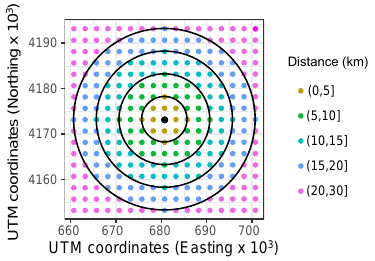
Figure 7. Case example: distribution of datasets (UTM